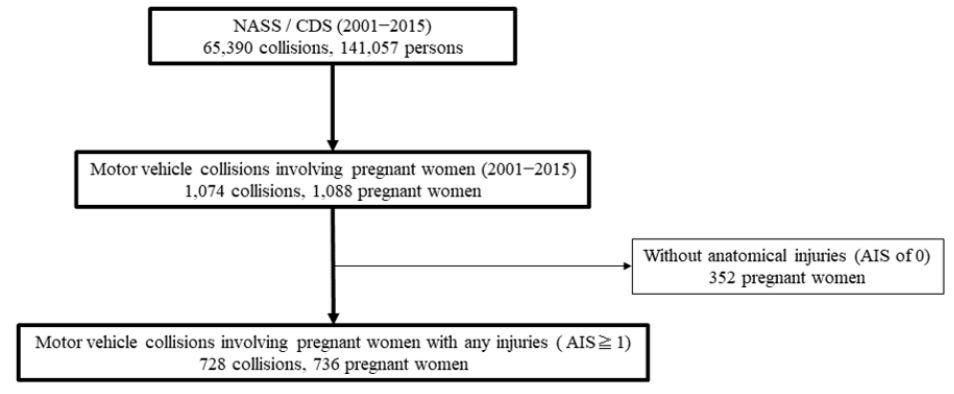
Figure 1. Flowchart of patient